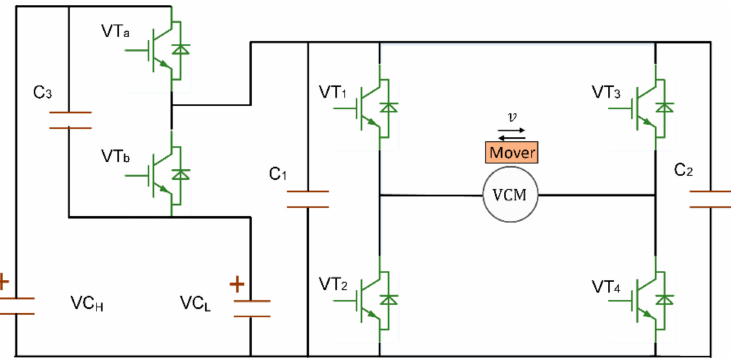
Figure 10. The H-Bridge circuit of LEM.